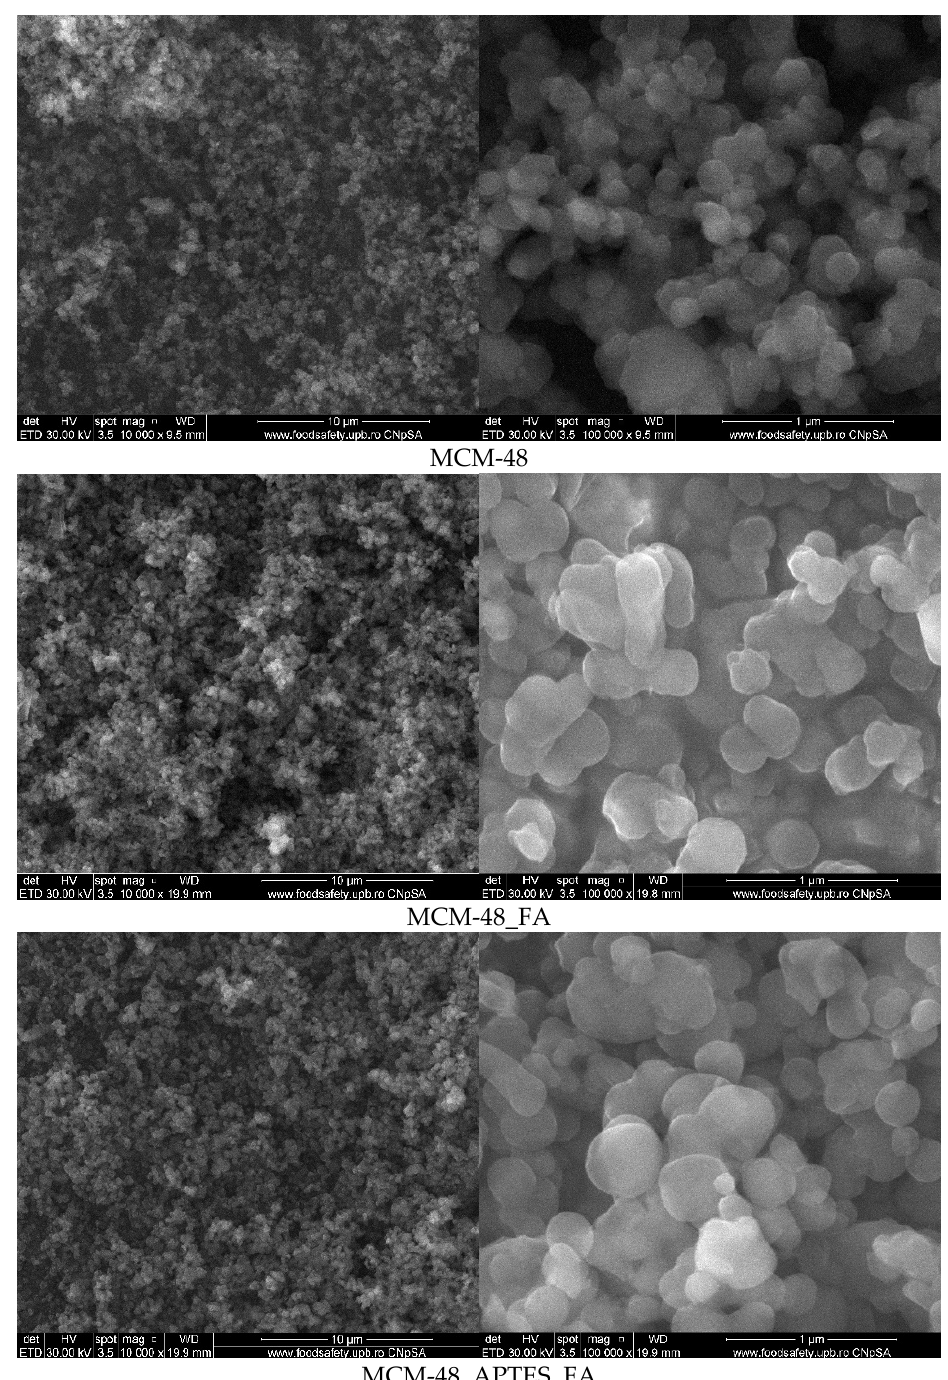
Figure 7. SEM micrographs for mesoporous materials based on MCM-48